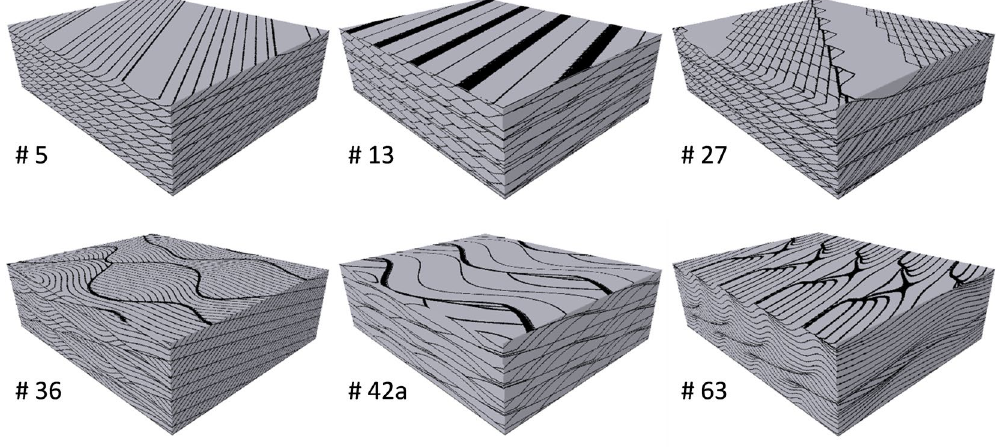
Figure 1. Six examples of 3D bedform architecture models (BAM) with associated numbers for specific figures from Rubin and Carter 26 . Black lines represent laminae that define bedforms with characteristic descriptive and process-based understanding. Horizontal and vertical scales are user-defined, but typically 10’s of centimeters.